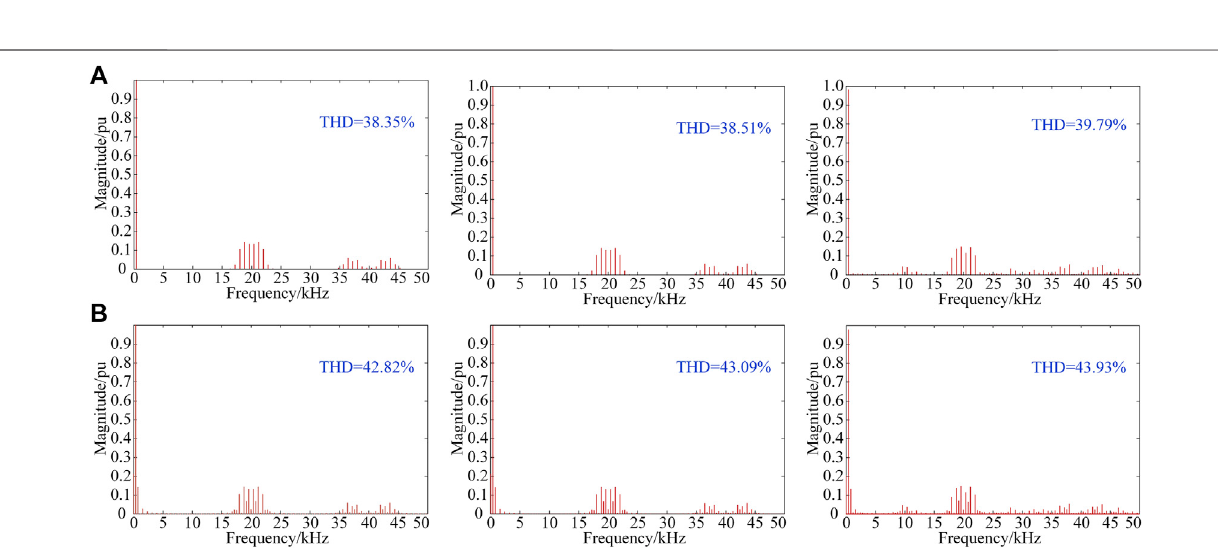
FIGURE 11 | Harmonic spectrums of phase voltage for calculation, simulation and experimentation: (A) balanced, (B) unbalanced.